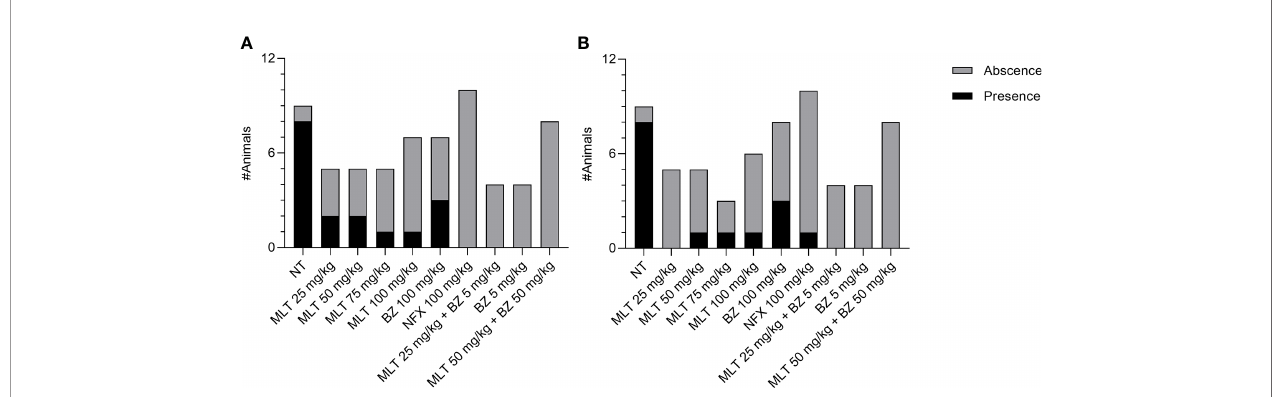
FIGURE 3 | Effect of miltefosine (alone or in combined regimes), benznidazole, or nifurtimox on amastigote nest burden in BALB/cJ mice infected Trypanosoma cruzi , (VD strain). Mice with the presence or absence of amastigote nests in skeletal muscle (A) and heart samples (B) . NT, infected non-treated. MLT, miltefosine. BZ, benznidazole. NFX, nifurtimox.